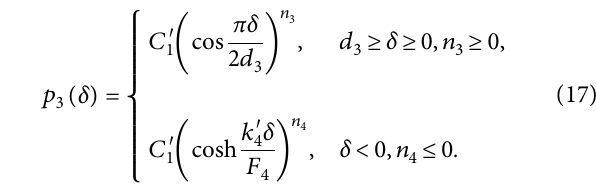
Figure 12: Displacement PDFs of AHTNPS for various damping